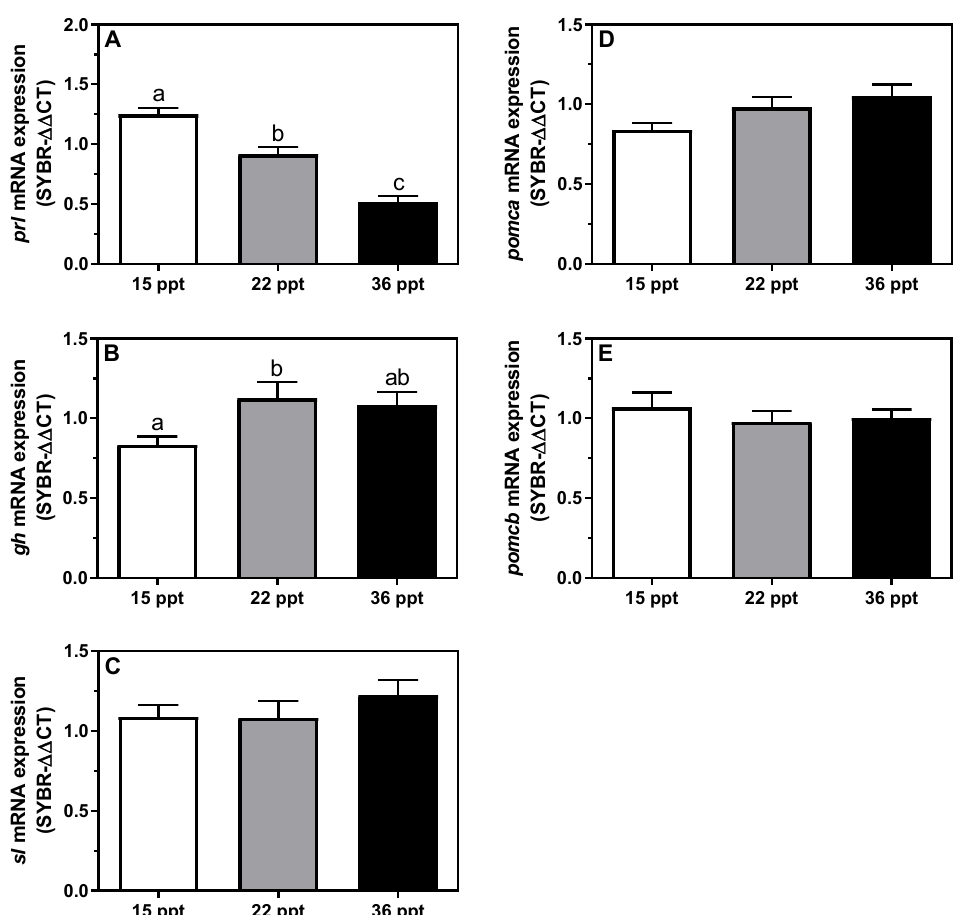
Figure 5. Changes in mRNA expression levels (relative to actb and eef1a ) of adeno-hypophyseal ( A ) prl , ( B ) gh , ( C ) sl , ( D ) pomca , and ( E ) pomcb in S. dumerili individuals acclimated to different environmental salinities (15, 22, and 36 psu). Data are presented as mean ± SEM (n = 9–12). Different superscript letters indicate significant differences among salinities ( p < 0.05, one-way ANOVA followed by Tukey´s post hoc test).